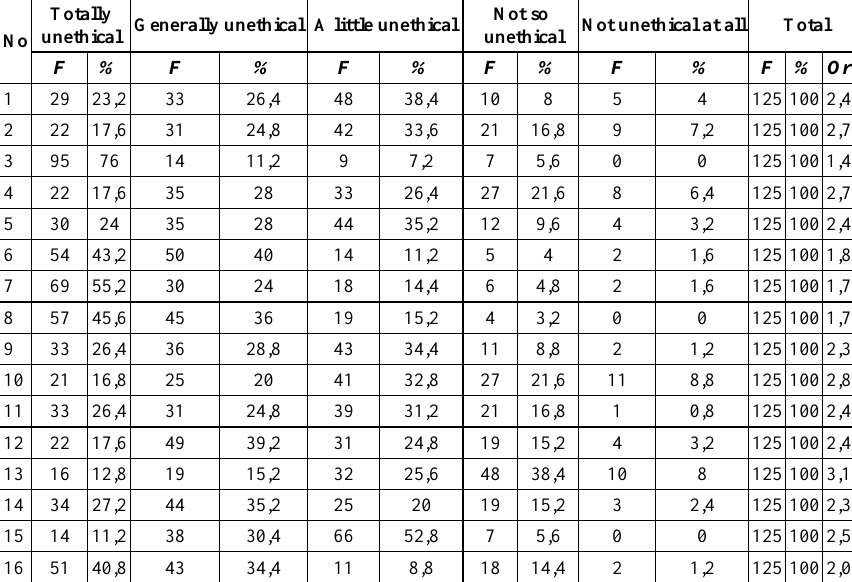
Table 5. Ethical perceptions of students regarding the behaviour of their